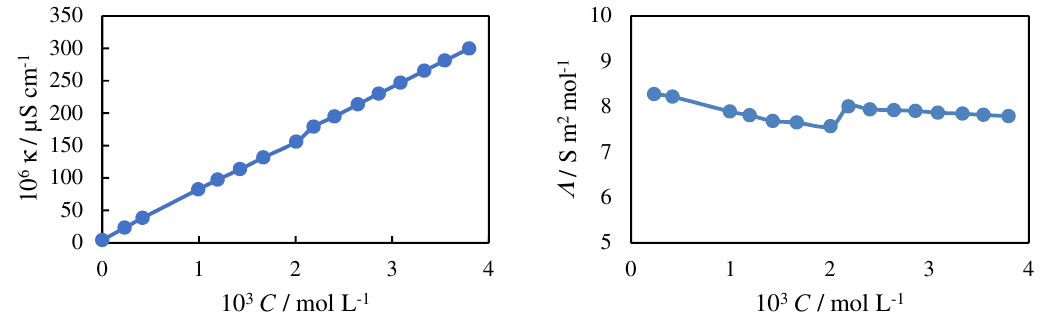
Figure 1. The ( a ) conductance and ( b ) molar conductivity of aqueous solutions of [MOIM][Br] under atmospheric pressure at 25